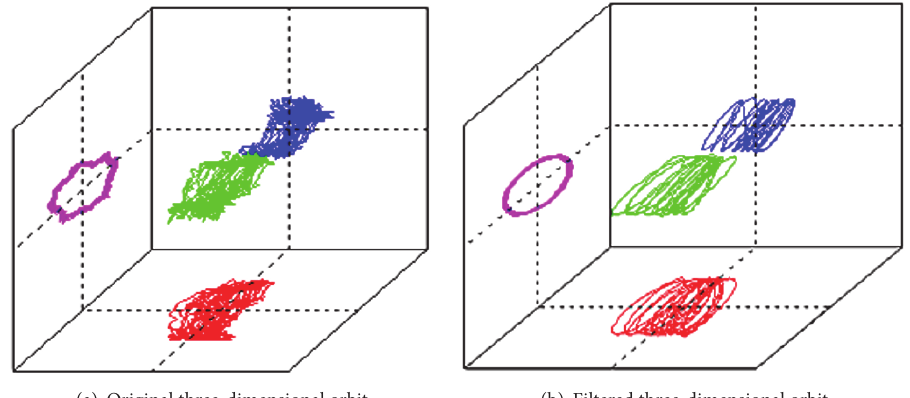
Figure 6: Original and filtered three-dimensional